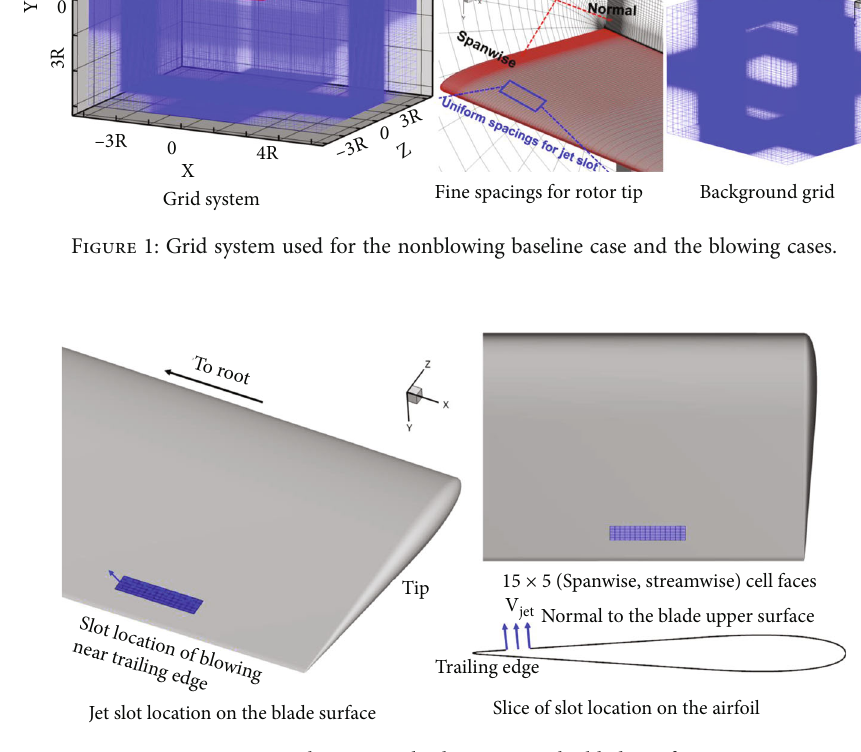
Figure 2: Blowing jet slot location on the blade